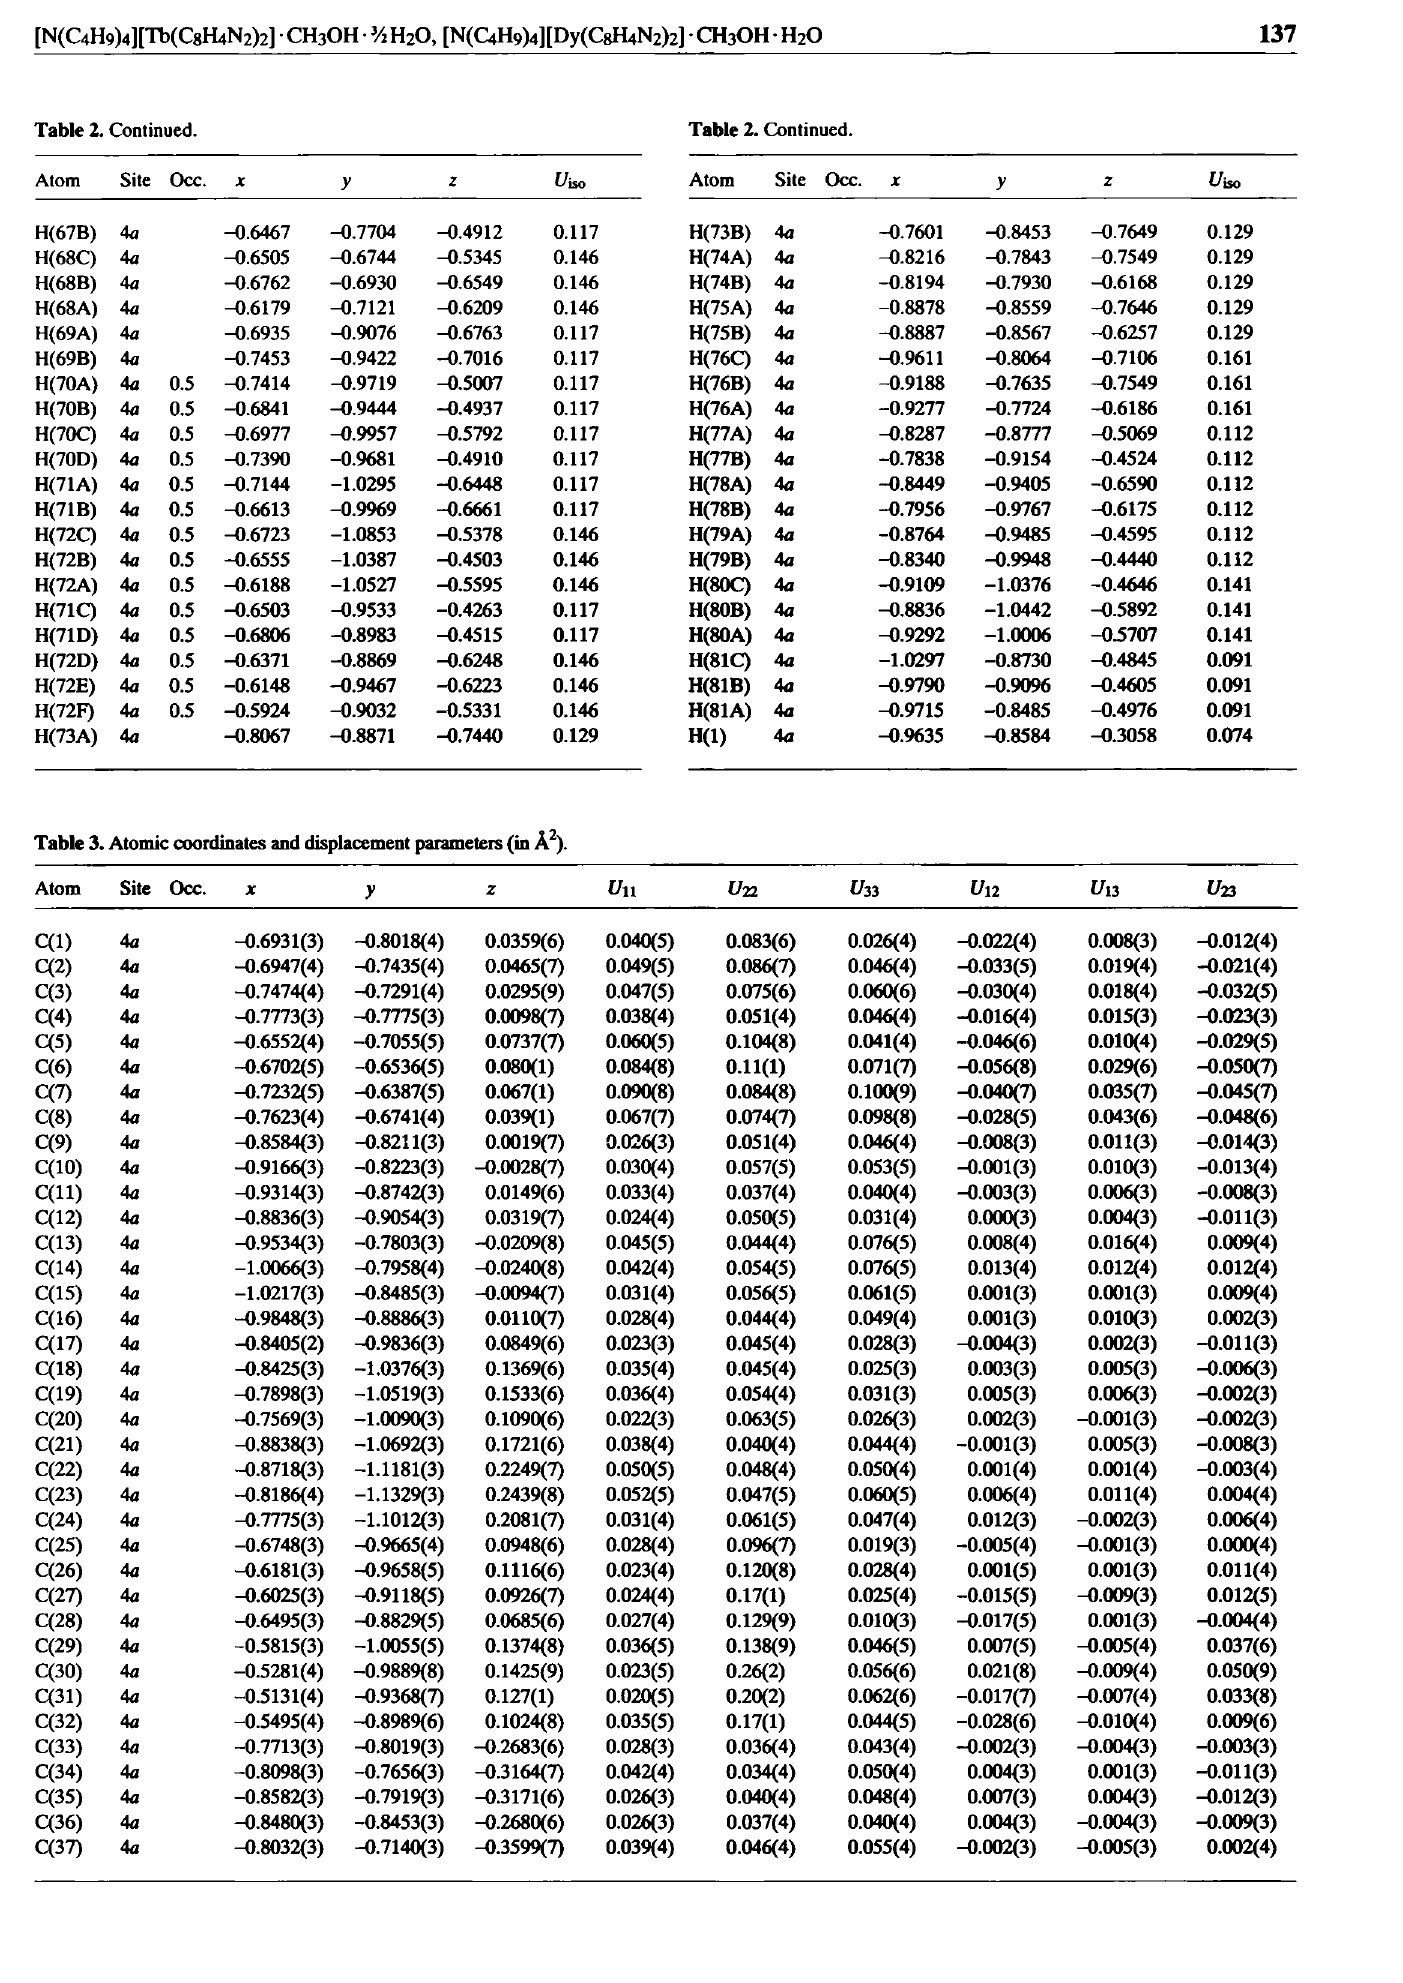
Table 3. Atomic coordinates and displacement parameters (in Ä 2